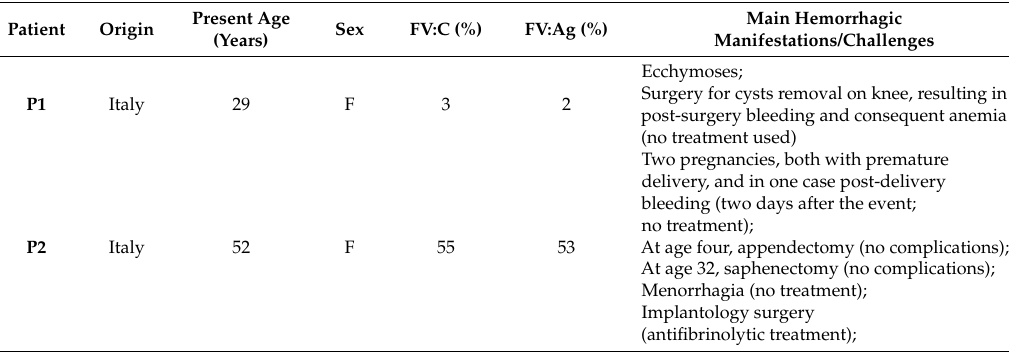
Table 1. Clinical data of the analyzed factor V (FV)-deficient